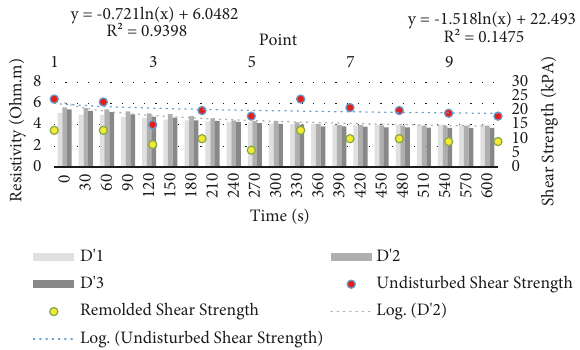
Figure 11: Line 4, in-situ test.